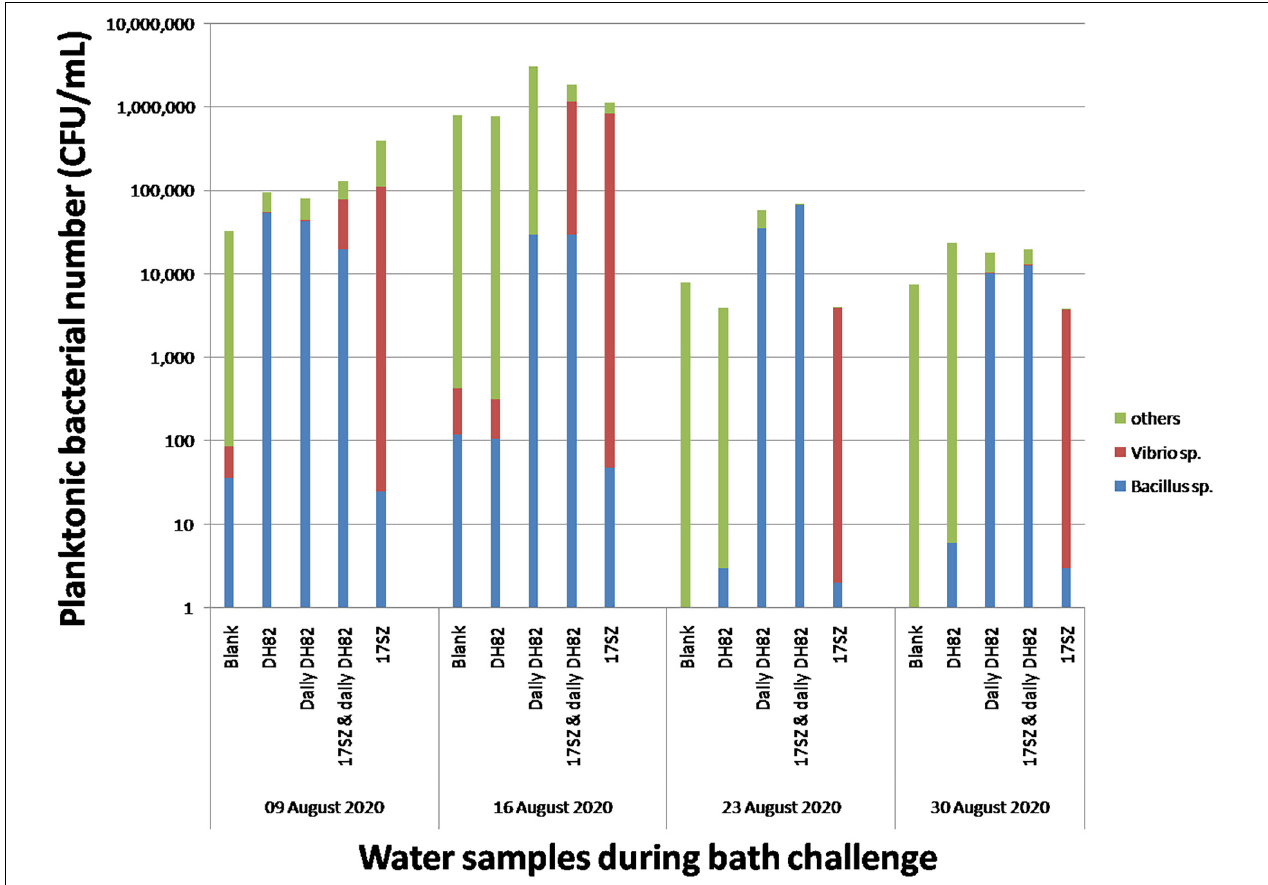
FIGURE 3 | Effects of DH82 on Vibrio control under bath challenge. Each 100 mL bacterial culture (OD 600nm 0.1) was individually poured into aquaria for bacterial bath challenge to white shrimps with the final concentration of 10 5 CFU/mL. The water samples in each group were collected before water exchange and spread on Luria–Bertani (LB) agar plates to calculate the bacterial number of Bacillus sp. and total amount, and on SCPB agar plates to calculate the number of Vibrio sp. The number of Bacillus sp. is presented by column in blue, Vibrio sp. in red and other bacteria in green. The vertical axis in the stacked column graph is marked as a logarithmic scale. TABLE 3 | Richness and diversity of intestinal bacterial community. Sample